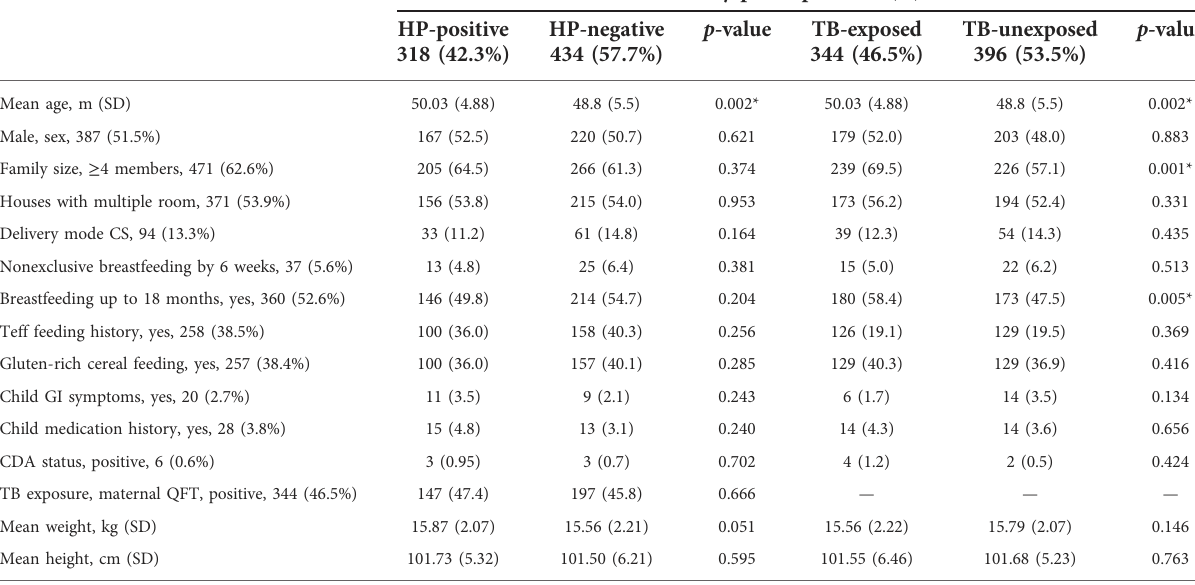
TABLE 2 Characteristics of study population strati fi ed by HP ( n =752) and LMTB ( n =740). Variable Study participants, N (%)